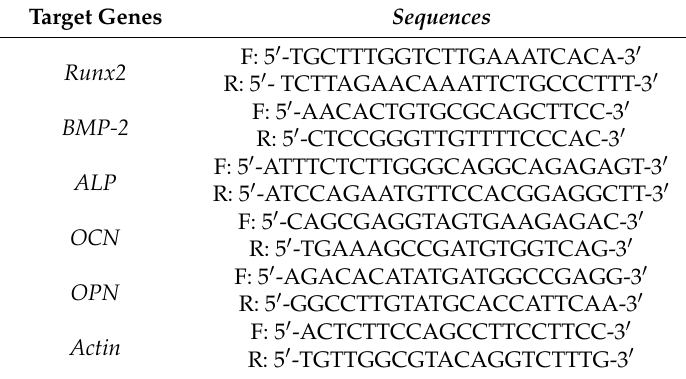
Table 3. Primer sequences used for real-time PCR